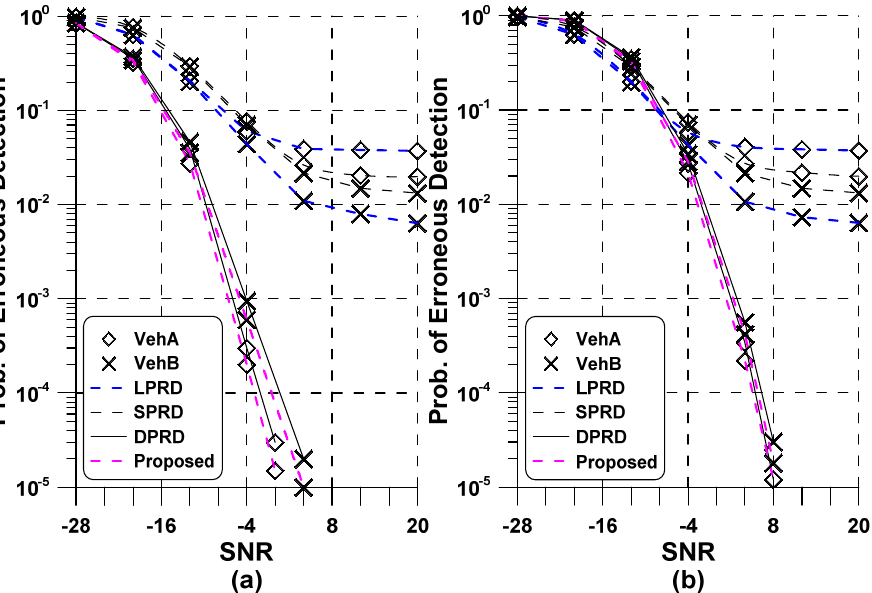
Figure 3. Performance comparison of the benchmark and proposed methods versus SNR in the vehicular channel models: ( a ) perfect channel ( b ) estimated channel.